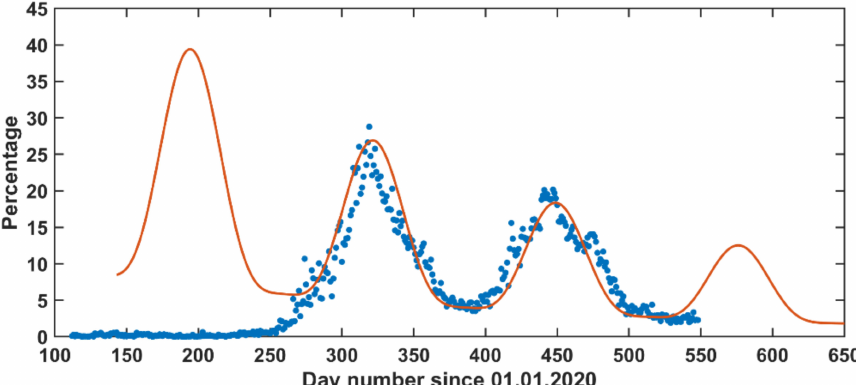
Figure 9. Long-term forecast (LTF) model (Equation (2)) for the COVID-19 pandemic in Jordan based on the positive qPCR cases out of the performed daily tests (as percentage out of the total qPCR daily tests). Legend: (dots) reported and (line)